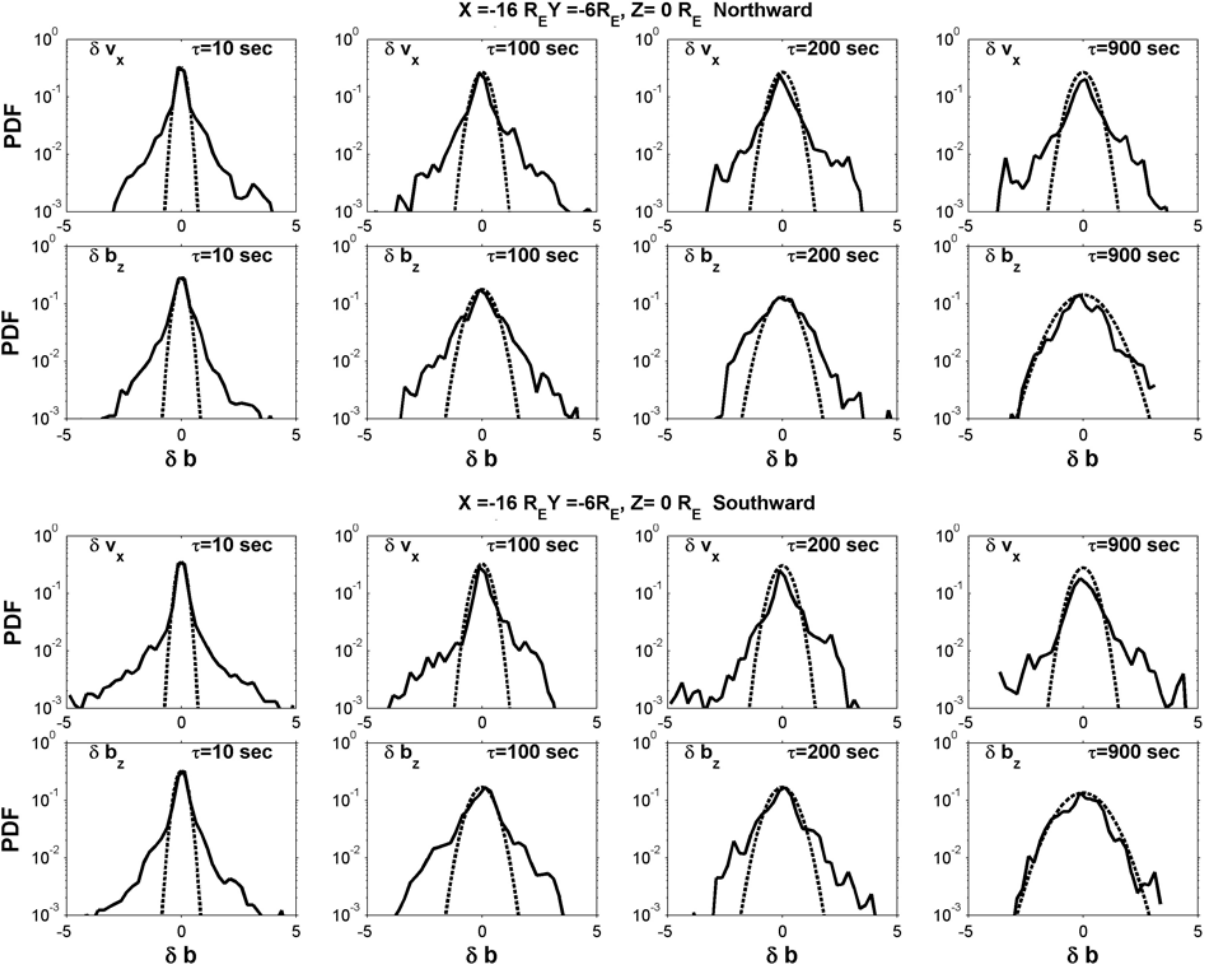
Fig. 7. Probability Distribution Functions (PDFs) in the plasma sheet. The top row is calculated from the x component of the flow during northward IMF, the second panel is calculated from the z component of the magnetic field during northward IMF, the third panel is from the x component of the flow during southward IMF and the bottom panel is from the z component of the magnetic field for southward IMF. The four columns of PDFs are computed by using different lag